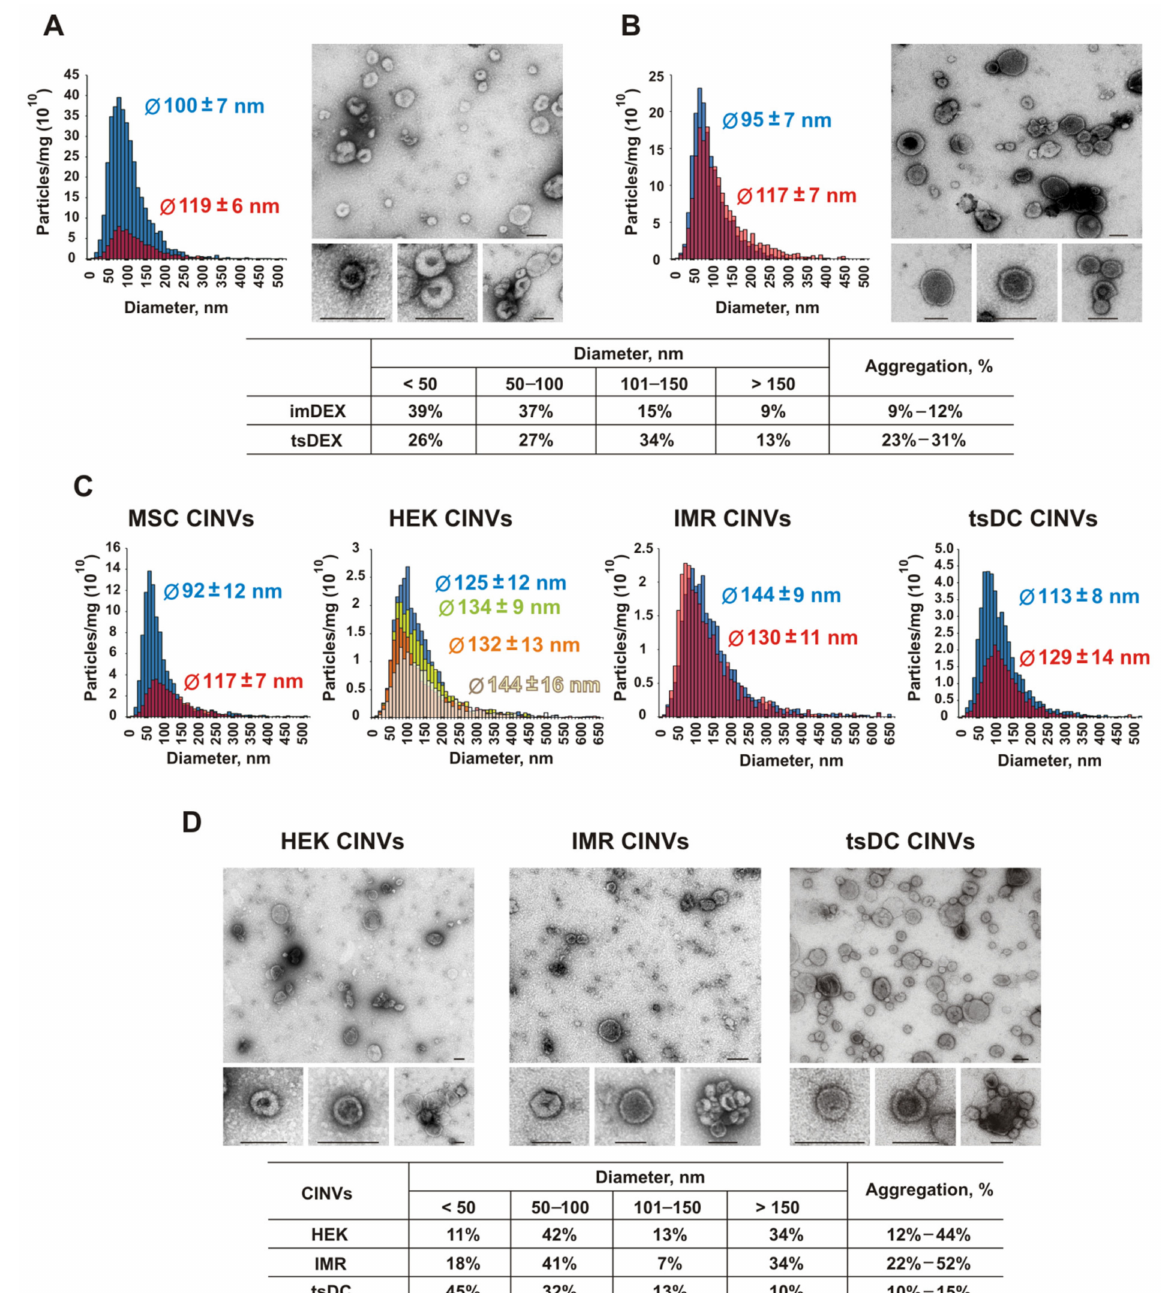
Figure 1. Analysis of size distribution and morphology of EVs and CINVs using NTA and TEM. ( A )–imDEX, ( B )–tsDEX, ( C , D )–data, obtained for CINVs, derived from various cell types. Histograms show the size distribution of EV or CINV samples measured by NTA: each color corresponds to data obtained for independently isolated samples. The number of particles was calculated by NTA in 1 mg (total protein) of EVs or CINVs diluted in 1 mL of buffer. The vesicle diameter [Ø] obtained by NTA is presented as the mean ± 95% confidence interval (CI 95 ). TEM data are presented as microphotographs with scale bar = 100 nm and tables showing the distribution of the nanovesicles between four groups with diameters [Ø] < 50 nm, 50–100 nm, 101–150 nm, and >150